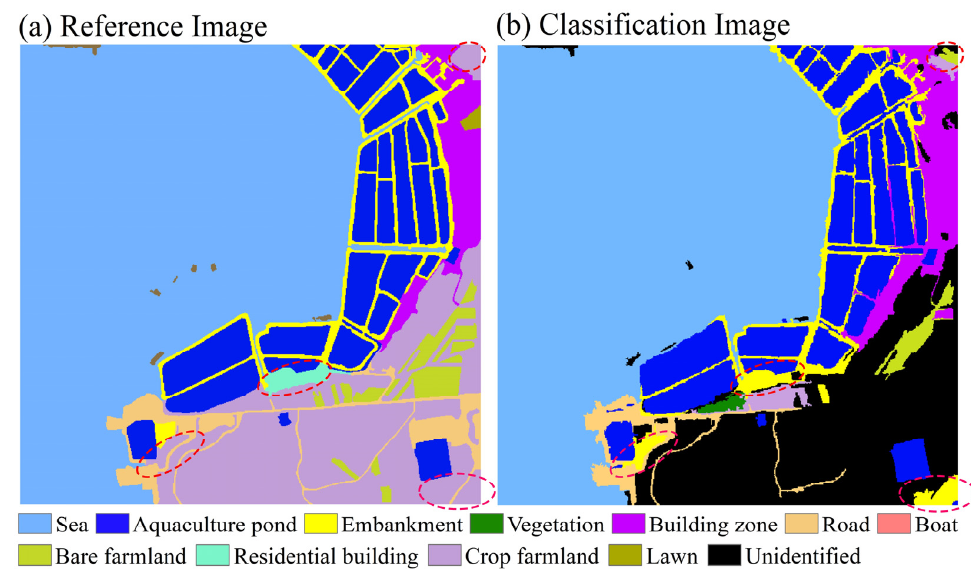
Figure 14. Results of using the knowledge graph in scene A to classify scene B. Different background colors in the imagery represent different land covers.